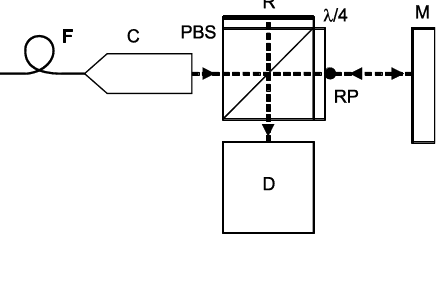
Figure 2. Schematics of the single-pass interferometer with a plane mirror reflector. PBS: polarizing beam splitter; M: plane mirror; C: collimator; λ/4: retardation plate; D: detection unit; F: optical fiber; R: reflective surface; RP: reference